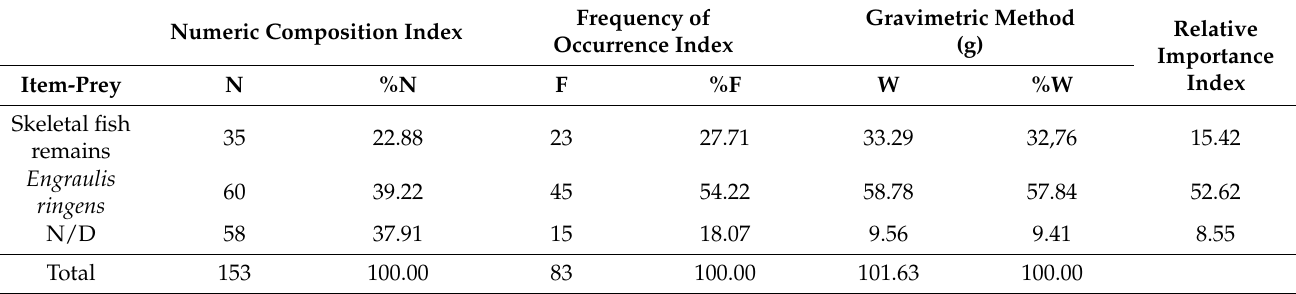
Table 3. Frequency of occurrence (%F), Numerical (%N), Gravimetric (%W) and Relative Importance